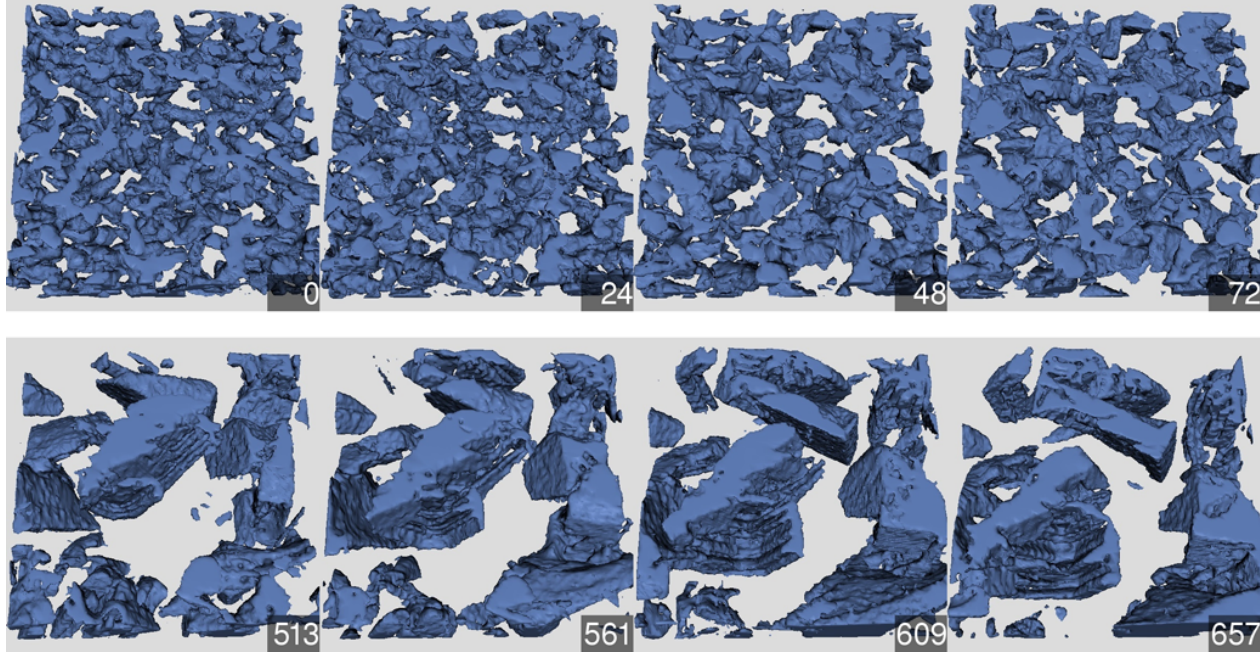
Fig. 5. Structural evolution of Series 2, observed in a subvolume ( 0 . 9 × 3 . 6 × 3 . 6mm 3 ) of the measured field of view. The temperature gradient is pointing downward along the z -axis, as defined in Fig. 2 The upper row shows the structural changes during the first 72h (every 24h), the lower row shows the same subvolume during the last 144h of the experiment (every 48h). Due to the non-destructive nature of the experimental technique, we can observe a cup crystal growing in an undisturbed environment. The non-destructive character of the measurements allows for a direct observation of deposition sites of the water molecules. A video showing the complete time series consisting of 83 tomographic measurements is provided in the